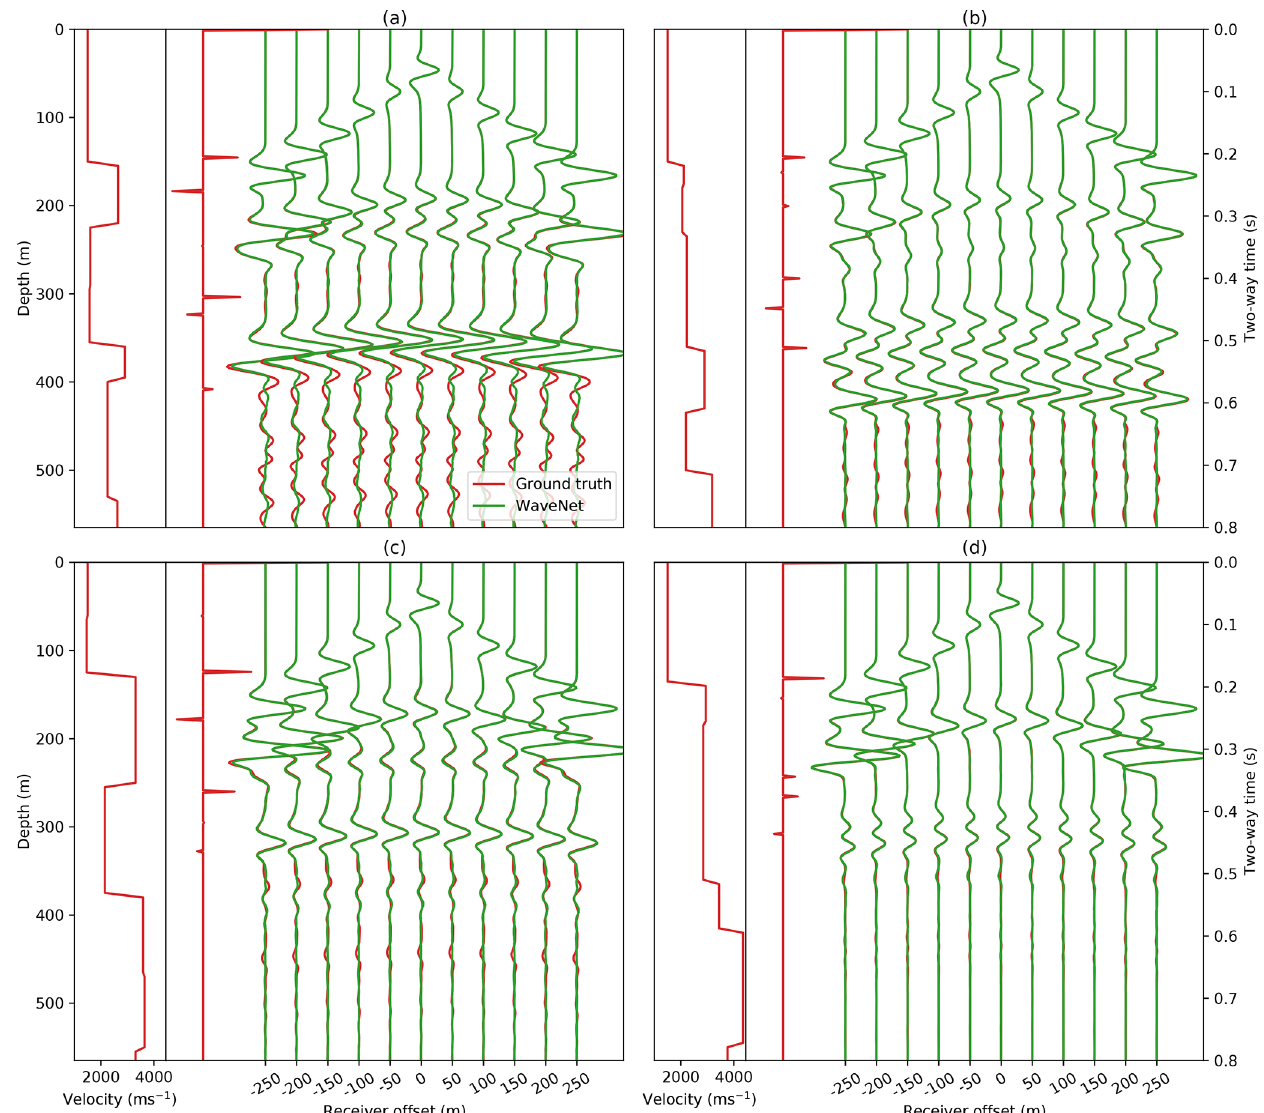
Figure 4. WaveNet simulations for four randomly selected examples in the test set. Red shows the input velocity model, its corresponding re- flectivity series and the ground truth pressure response from FD simulation at the 11 receiver locations. Green shows the WaveNet simulation given the input reflectivity series for each example. A t 2 . 5 gain is applied to the receiver responses for